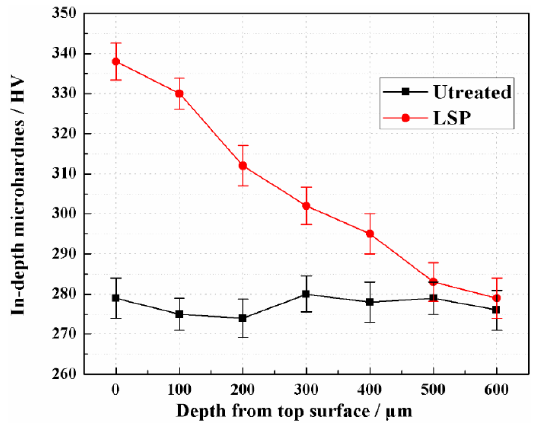
Figure 9. Microhardness at the depth direction of the samples without and with